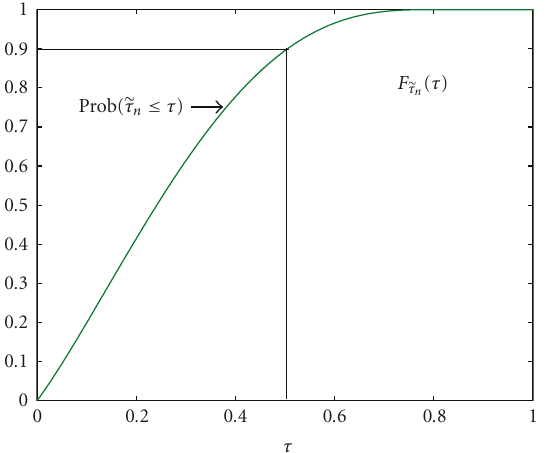
Figure 14: CDF of (cid:9) τ n , F (cid:9) τ ( τ ) in DVD for v min = 2m/s. n